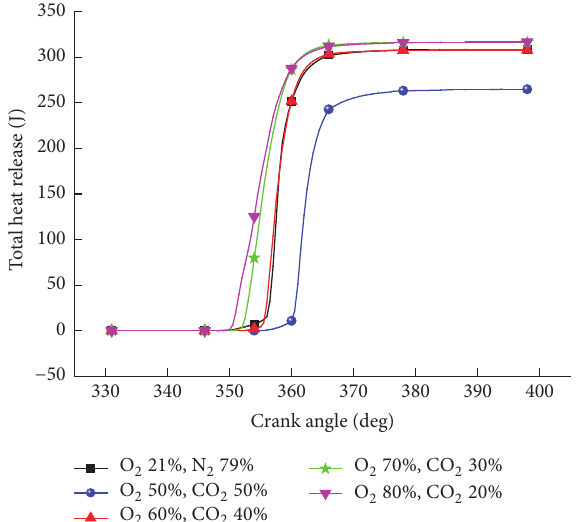
Figure 10: Heat release in the environment of different high O 2 volume fraction.